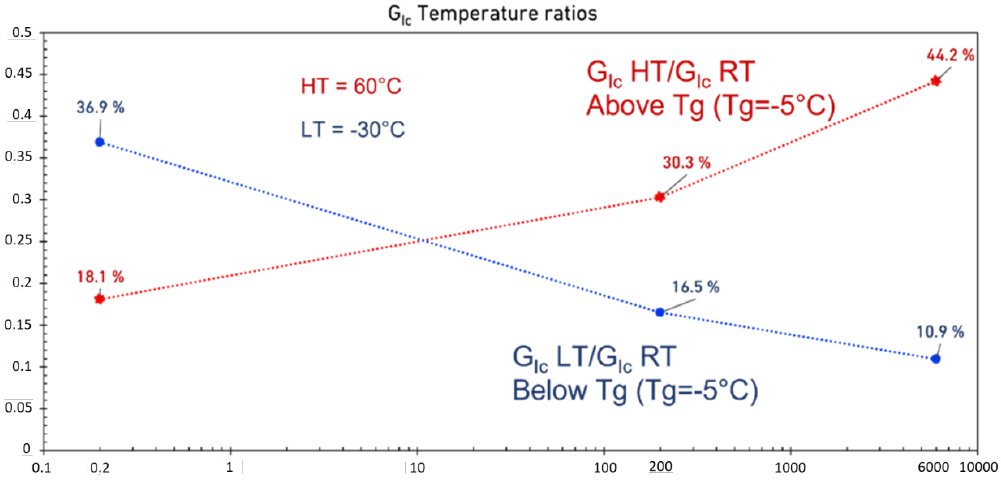
Figure 10. Mode I fracture energy temperature ratios between both HT and RT (red curve), and LT and RT (blue curve).